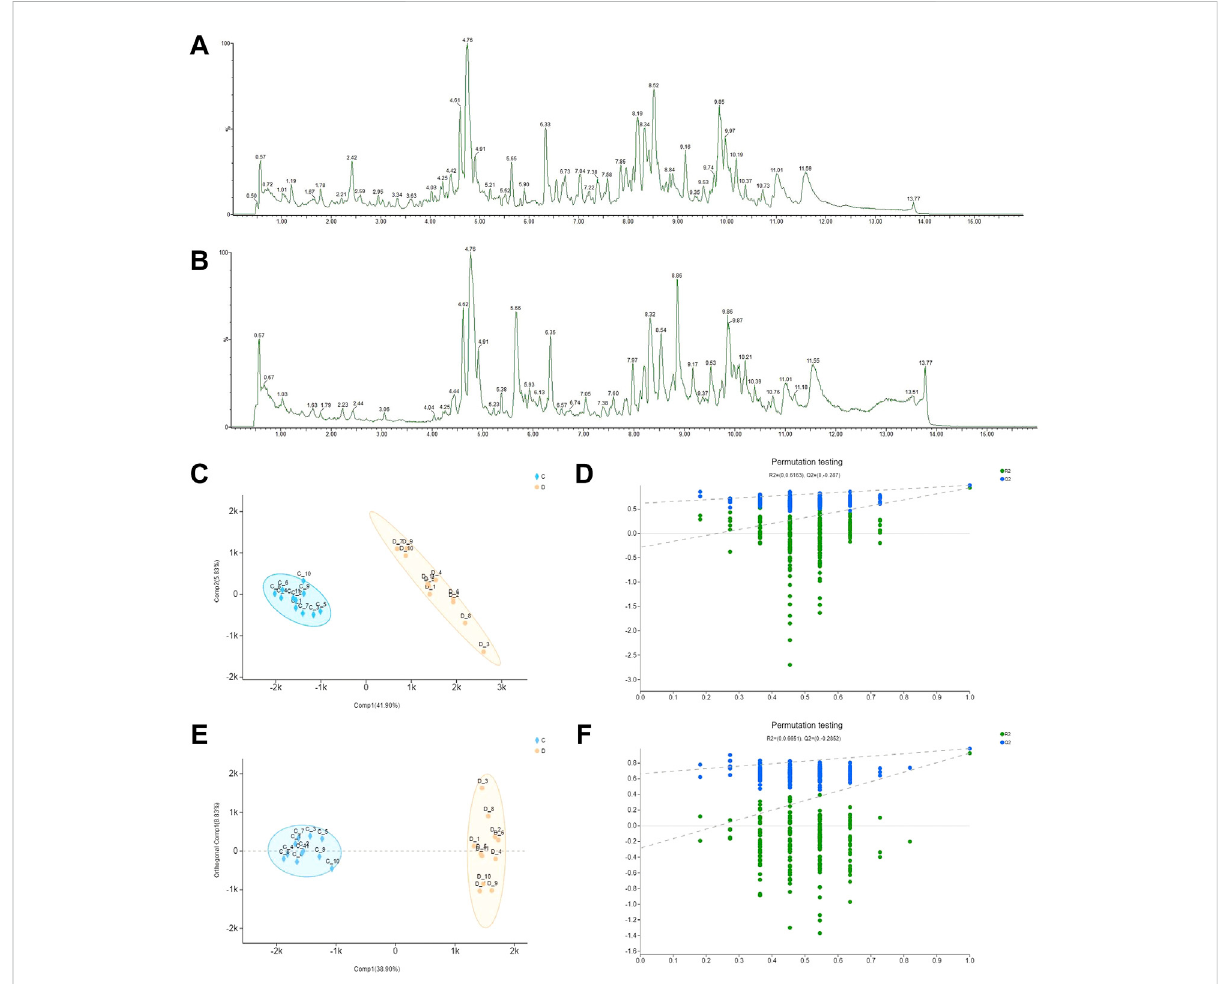
FIGURE 1 Differential metabolites between mountain-cultivated ginseng (MCG) and garden ginseng (GG) determined by ultra-high-performance liquid chromatography-quadrupole time-of- fl ight tandem mass spectrometry. The total ion chromatograms of MCG and GG in negative ions. (A) MCG and (B) GG. The results of statistical analysis from the ginseng samples. (C) Partial least squares discriminant analysis (PLS-DA) score plot, (D) permutation test, (E) orthogonal partial least squares discriminant analysis (OPLS-DA) score plot, and (F) permutation